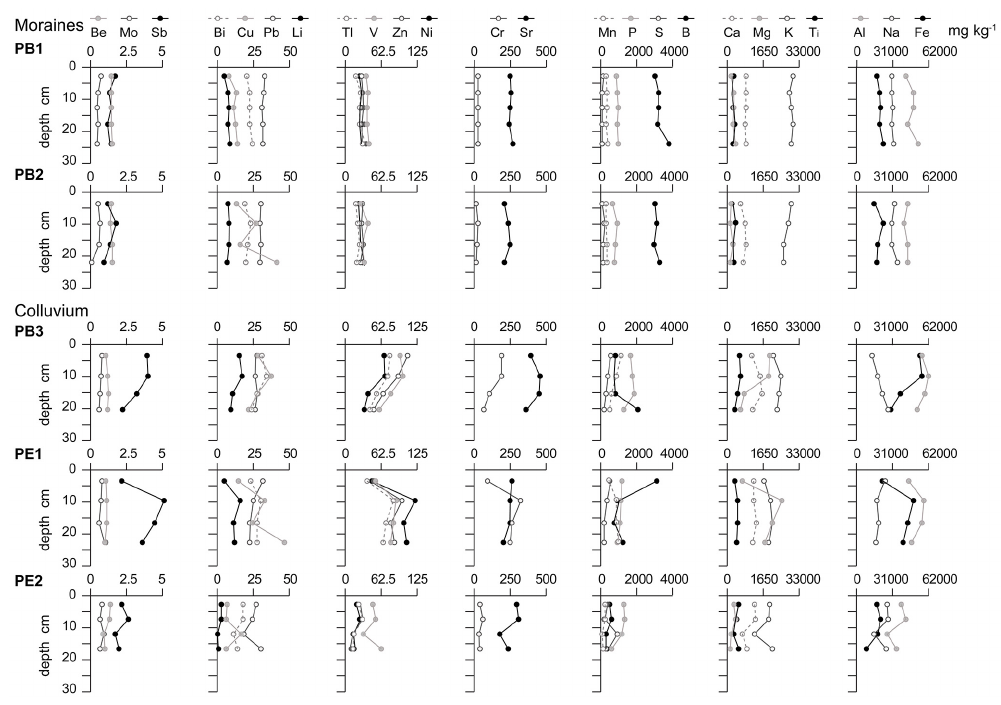
Figure 5. Vertical distribution of the chemical elements (mg kg − 1 ) in the soil profiles on the moraines and colluviums.